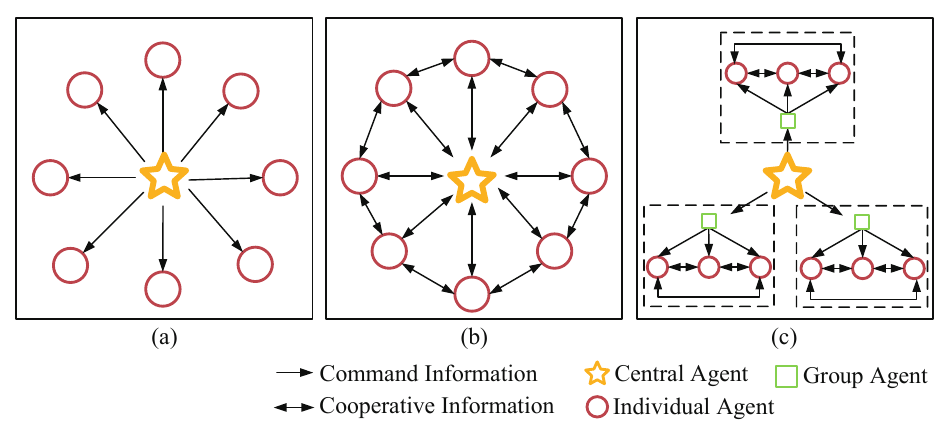
Figure 3. Typical multi-agent-based defense system architectures. ( a ) The thoroughly central system. ( b ) The thoroughly distributed system. ( c ) The hierarchical distributed system. Algorithm 1: Dynamic grouping algorithm based on the defense objective